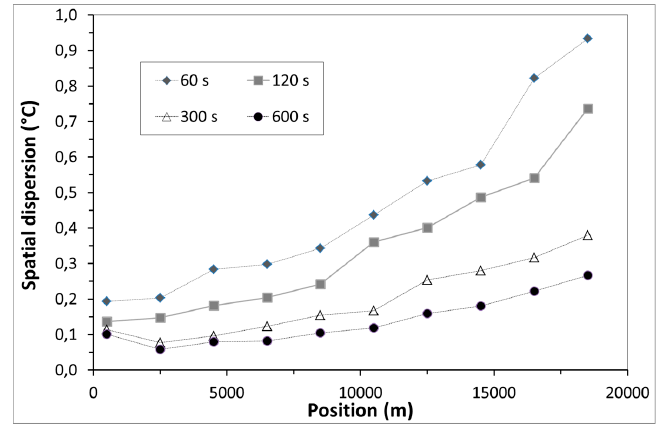
Figure 13. Measured temperature uncertainty (°C) as a function of the optical fibre length (m) at different averaging measurement times over at 23 °C and 1m spatial resolution.